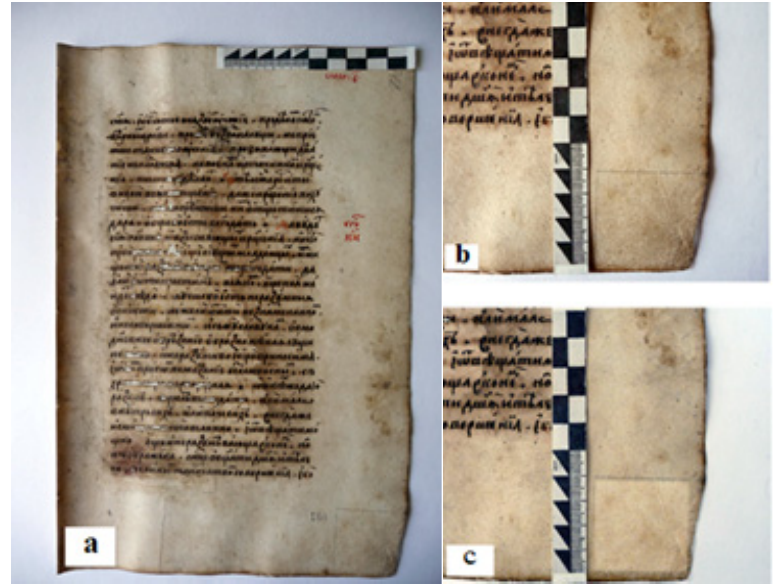
Figure 5. Page of a Russian handwritten book of the XVII century with characteristic surface contamination: ( a )—the initial state; ( b )—the lower right corner marked with a pencil—the experimental area for clearing with a laser; ( c )—the same section of the page after laser processing.